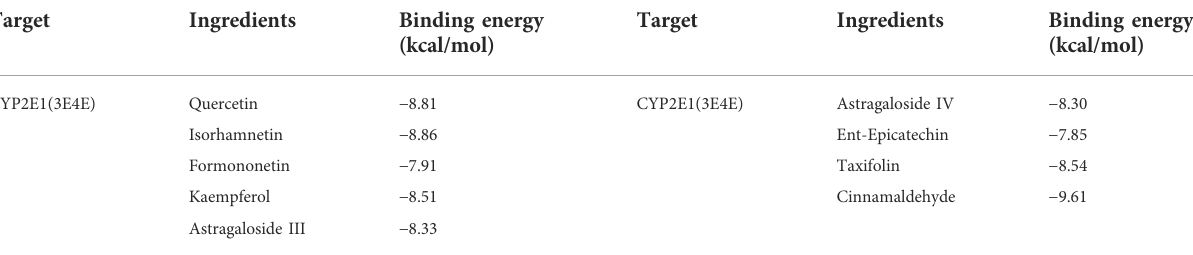
TABLE 4 Results of molecular docking studies of nine ingredients in the active sites of CYP2E1 performed using Autodock